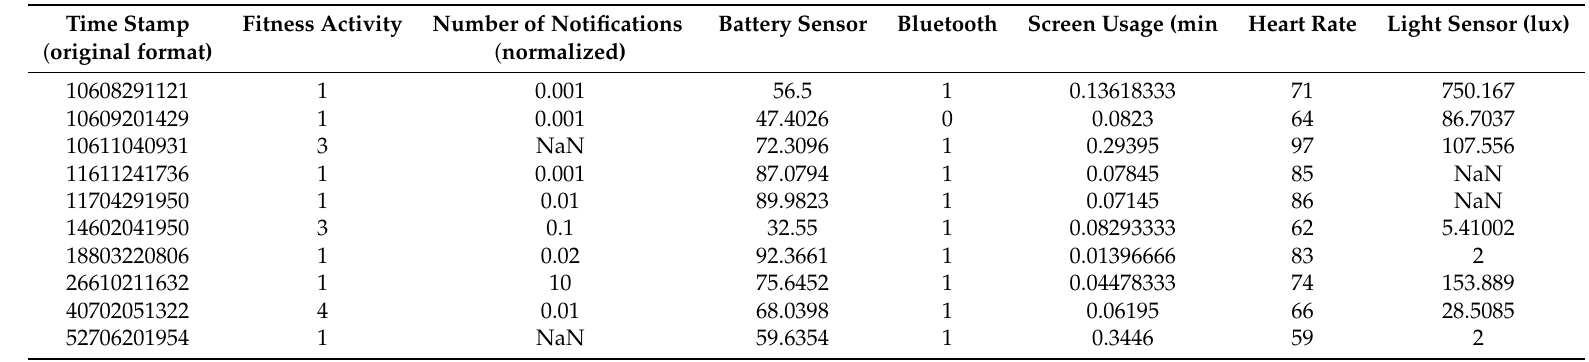
Table 3. Example illustration of sample data extracted from the raw data. For “Fitness Activity", “1” stands for an unknown activity, “2” is for Walking, “3” is for Still, and “4” is for In-Vehicle. “min” stayed for minutes and “lux” for